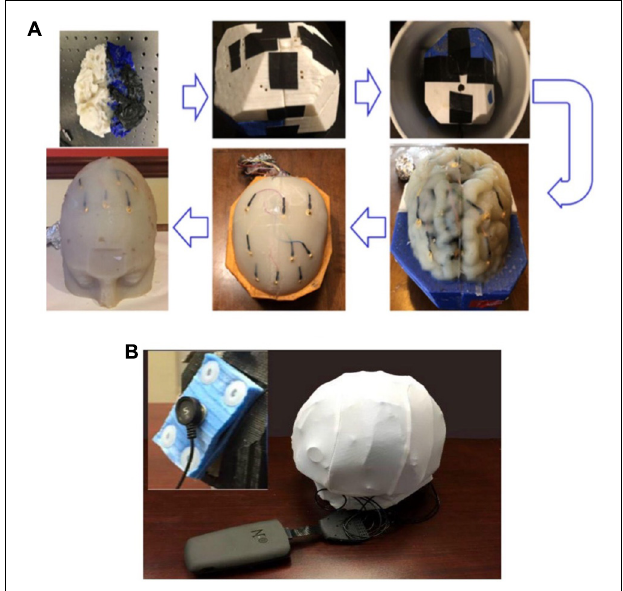
FIGURE 8 | (A) The process flow to fabricate the four-layer head phantom ∗ with embedded monitoring electrodes in the gray matter and skull layers; (B) a picture of the experimental setup to collect electrical responses with inset showing the rectangular tDCS electrode. ∗ Color differences are due to the different filaments used to fabricate the mold and have no impact on